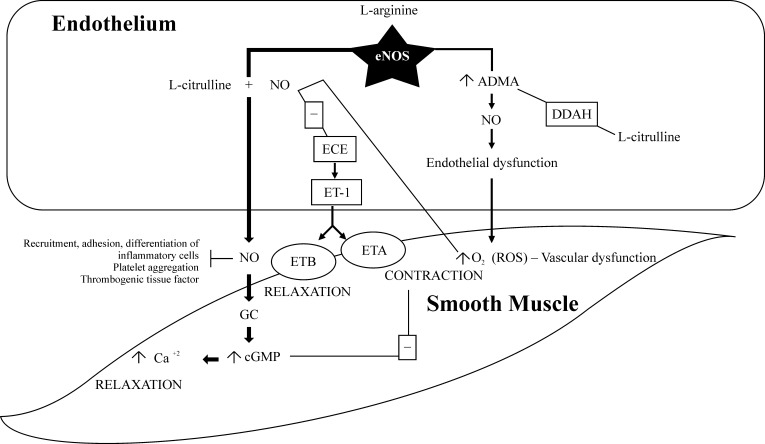
Endothelial signaling and mechanism of relaxation or contraction of smooth muscle. eNOS: endothelial nitric oxide synthase enzyme; NO: nitric oxide; GC: guanylate cyclase; cGMP: cyclic guanosine monophosphate; Ca2+: calcium ions; ECE: endothelin conversion enzyme; ET-1: endothelin 1; ETA, ETB: receptors for endothelins – ETA and ETB in vascular smooth muscle cells; O2: free radicals; ROS: reactive oxygen species; ADMA: asymmetric dimethylarginine; DDAH: dimethylarginine dimethylaminohydrolase.